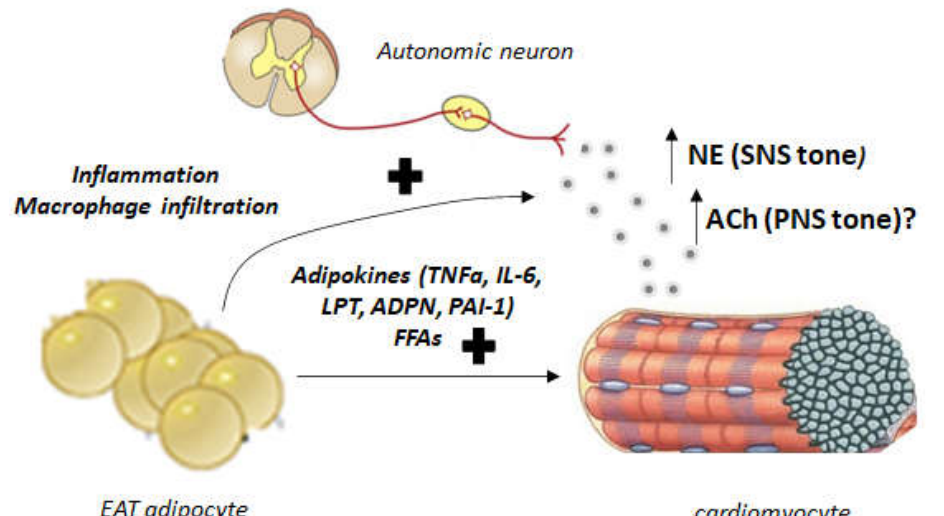
Figure 2. Pathophysiological interplay between EAT cells, autonomic neurons, and the myocardium. EAT dysfunction, caused e.g., by inflammation, increases SNS tone (NE release from sympathetic neurons), and, perhaps, PNS tone (ACh release) within the heart, through elevated secretion of adipokines and FFAs. This leads to sympathetic hyperactivity and autonomic dysfunction of the myocardial cells, contributing to heart failure, AFib pathogenesis, coronary heart disease, and other myocardial maladies. Of note, the very same adipokines and FFAs, whose secretion from EAT is increased, can also directly (i.e., independently of autonomic nerve activation) affect the cardiomyocytes, inducing apoptosis, inflammation, and other maladaptive processes that also contribute to heart failure progression. NE, Norepinephrine; SNS, Sympathetic nervous system; ACh, Acetylcholine; PNS, Parasympathetic nervous system; TNFα, Tumor necrosis factor-α; IL-6, Interleukin-6; LPT, Leptin; ADPN, Adiponectin; PAI-1, Plasminogen activator inhibitor-1; FFAs, Free fatty acids (saturated). See also text.